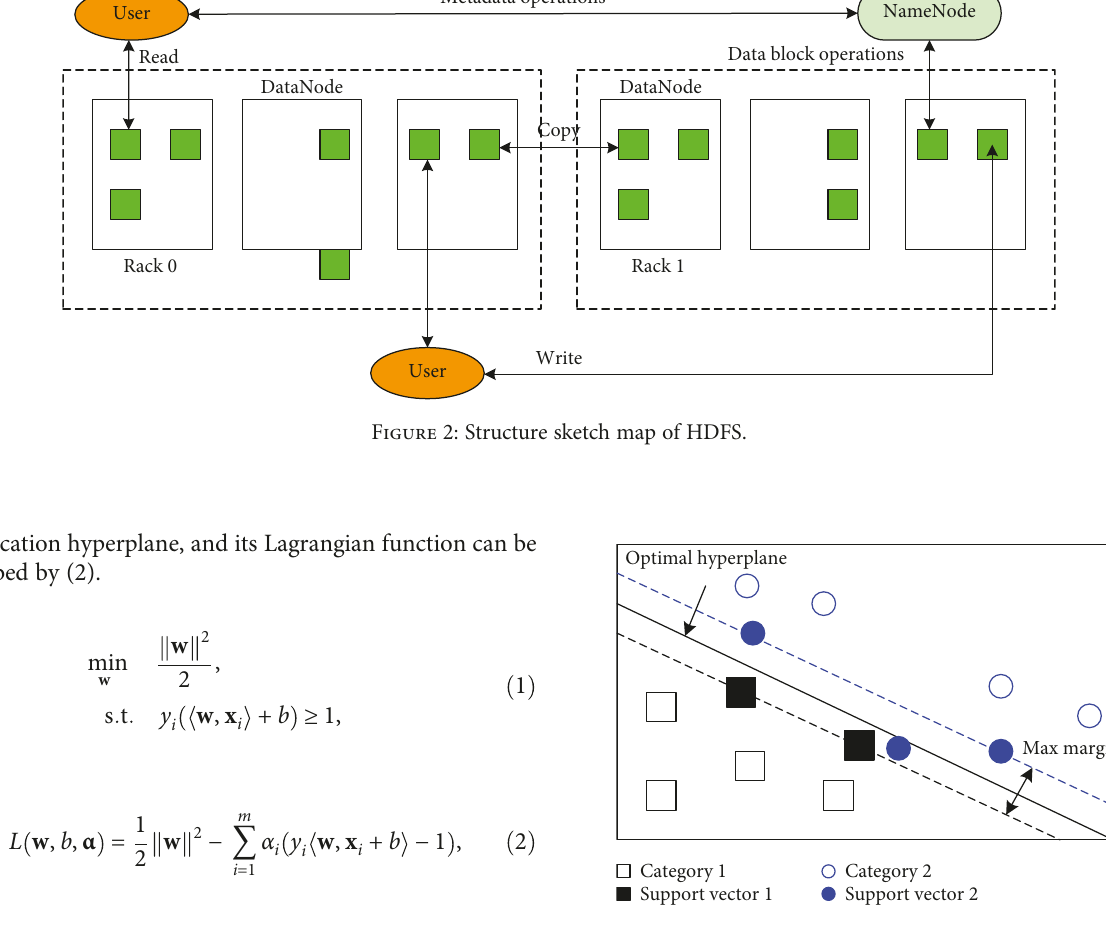
Figure 3: Linearly separable case of an SVM optimal hyperplane.